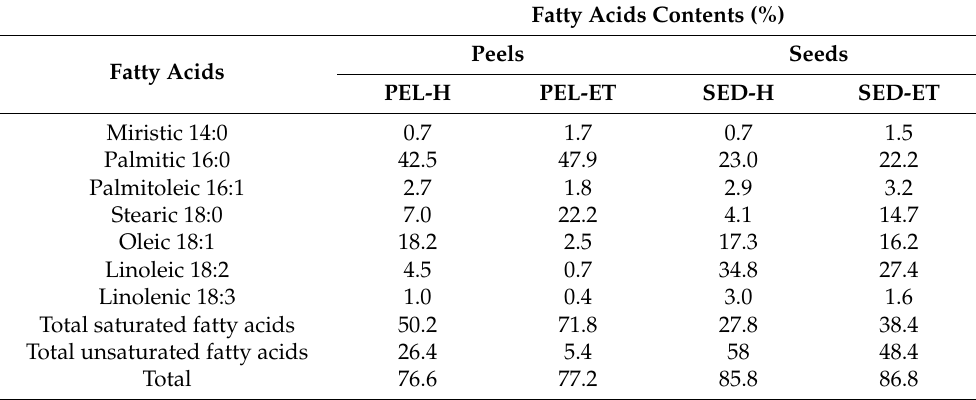
Table 2. Fatty acids composition of hexane and ethanolic extracts of avocado peels and